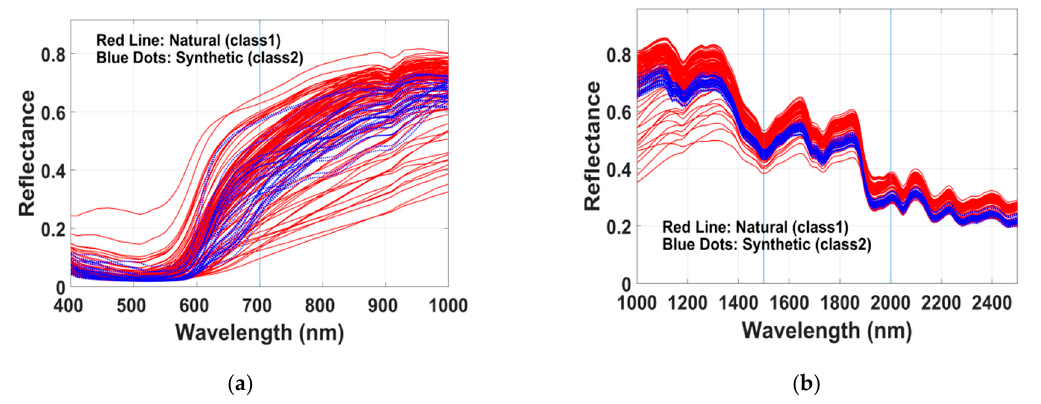
Figure 3. Reflectance spectra of 114 yarns dyed with natural Madder (solid red lines) and 34 samples dyed with synthetic red dyes (dotted blue lines): ( a ) the V/NIR range, ( b ) the SWIR range.